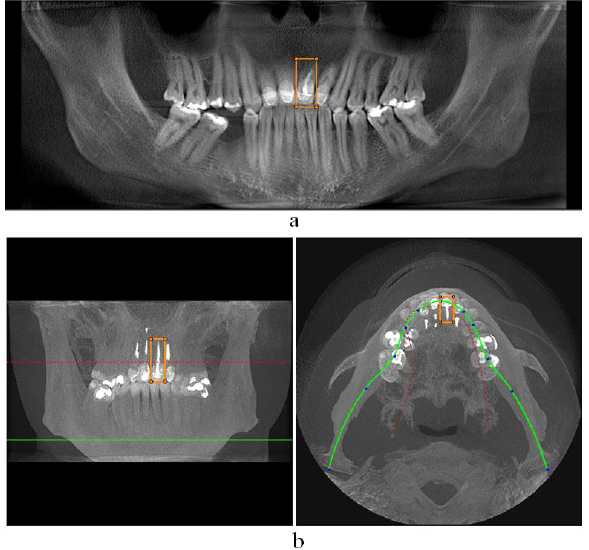
Figure 1. ROI detection: а manually by expert in panoramic image, b automatically based on the main projections